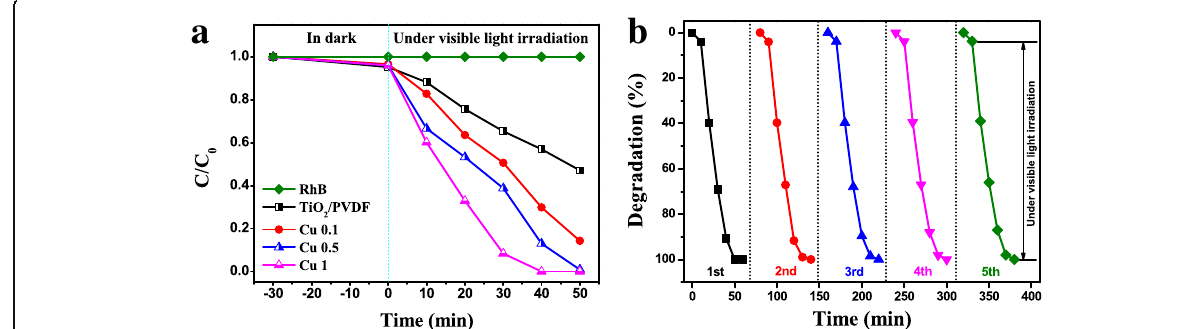
Fig. 7 a Photocatalytic degradation curves of RhB over the samples: RhB without photocatalyst, TiO 2 /PVDF, Cu 0.1, Cu 0.5, and Cu 1. b The recycle experiment using the sample Cu 1